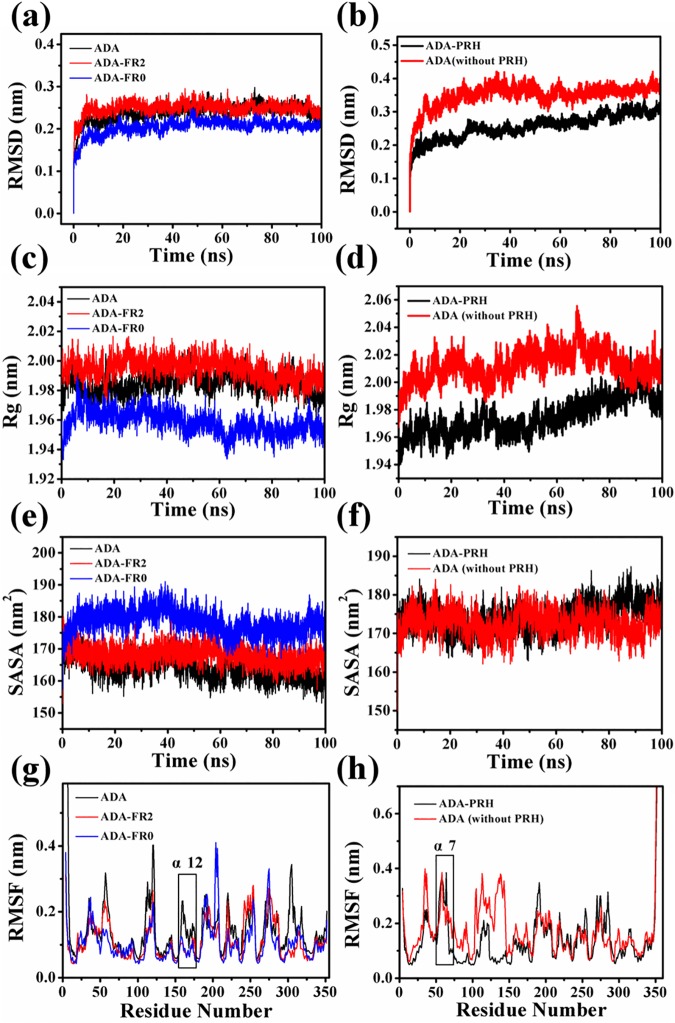
Structural stability of the five systems.(a) RMSD of C-α (c) radius of gyration (Rg) (e) SASA and (g) RMSF of three systems: ADA, ADA-FR2, and ADA-FR0. (b) RMSD of C-α (d) radius of gyration (f) SASA and (h) RMSF of the two systems: ADA-PRH and ADA (without PRH).